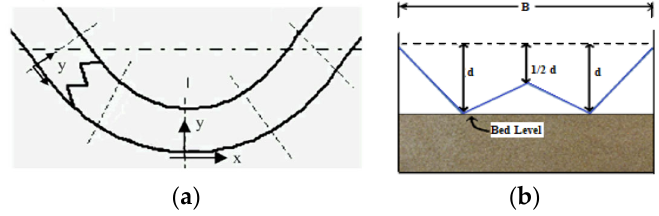
Figure 1. ( a ) W − Weir in the river bend and ( b ) the W − Weir shape [18].